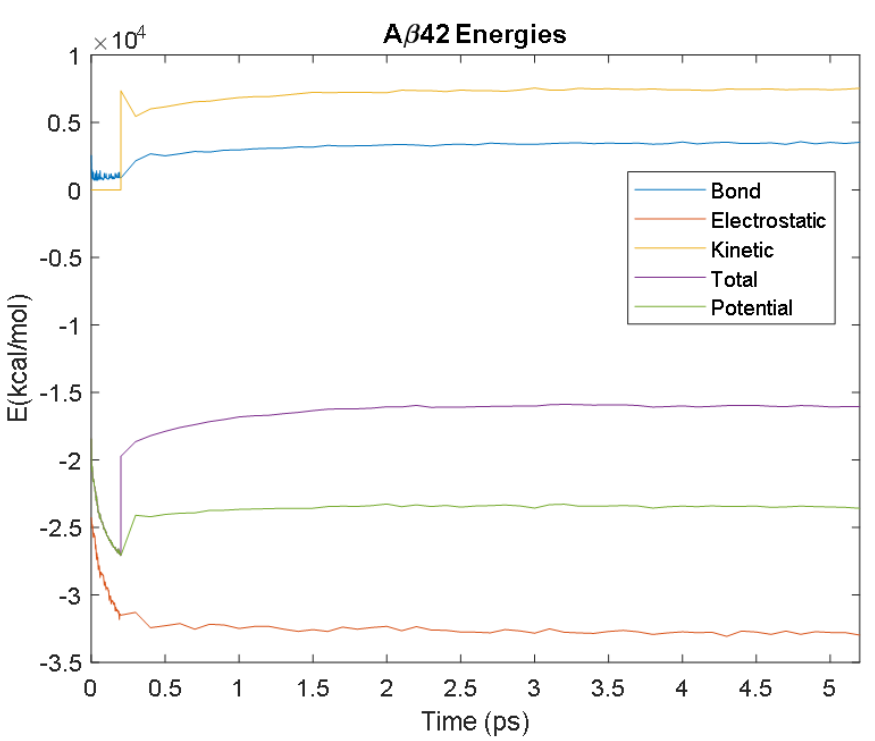
Figure 24. A plot of Aβ42′ s bond, electrostatic, kinetic, total, and potential energies over 5 ps from its simulation in NAMD.